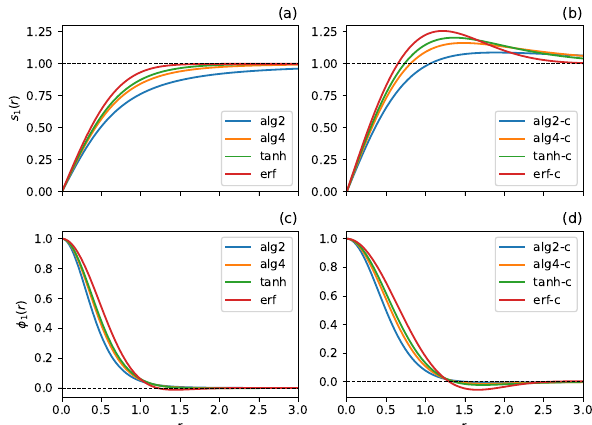
Figure 1. Behavior of the radially symmetric smoothing factors s 1 ( a , b ) and blob functions φ 1 ( c , d ) given in Table 1, plotted as a function of r = (cid:107) r (cid:107) . All smoothing factors have been normalized by (cid:112) φ 1 ( 0 ) in the arguments to s 1 , and the blob functions correspond to the normalized substituting r → r 3 smoothing factors. No boundary corrections are utilized in ( a , c ) whereas ( b , d ) incorporates the boundary-velocity correction given by